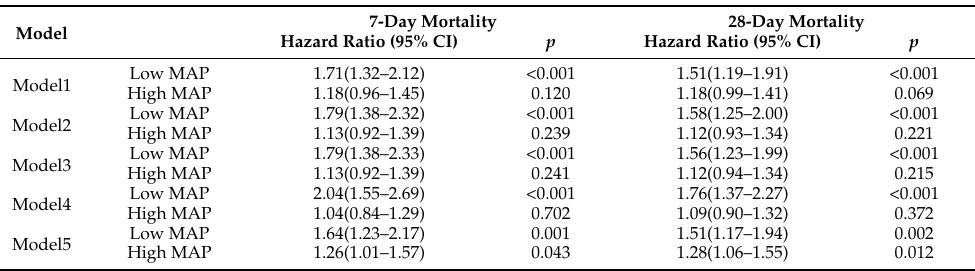
Table 2. Association between MAP and outcomes of stroke patients adjusted by multivariable Cox proportional hazards